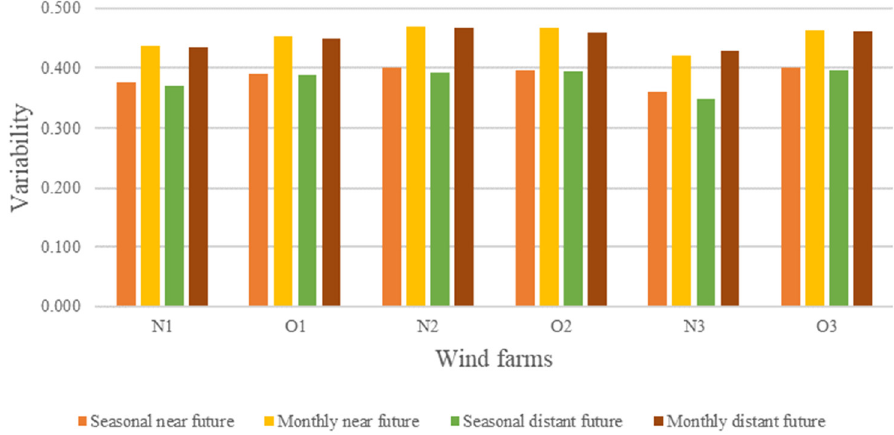
Figure 7. Seasonal and monthly variability of the wind speed.